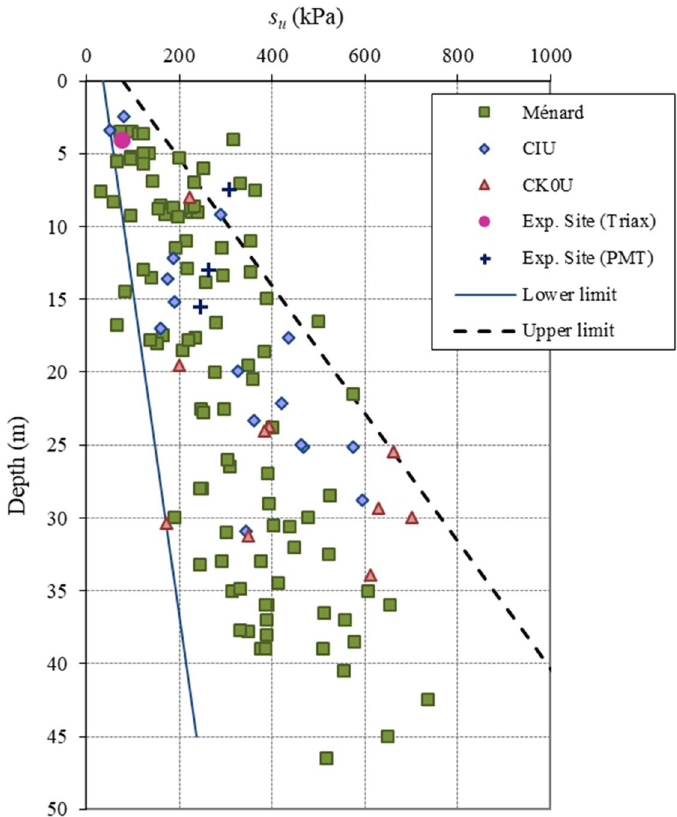
Fig. 13 Proposed trends for undrained shear strength in depth for Prazeres